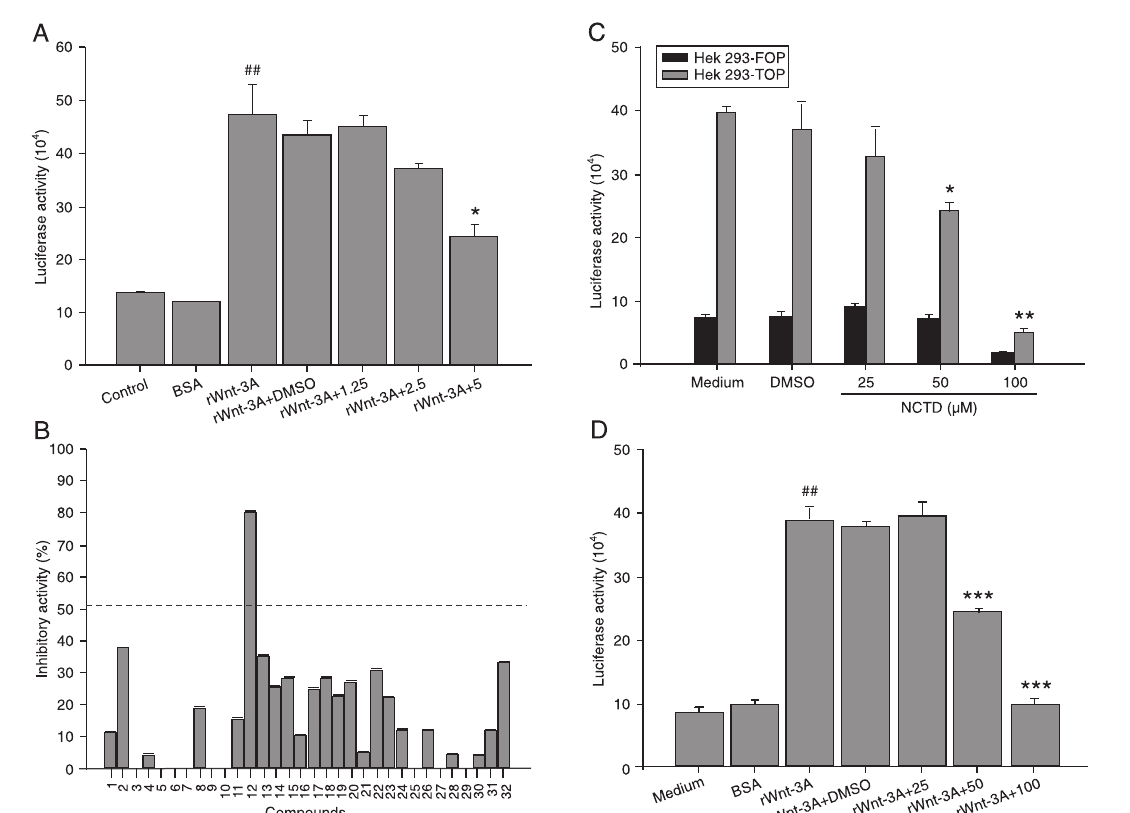
Figure 3. Effects of aspirin and 32 other compounds on luciferase activity in HEK 293-TOP cells induced with Wnt-3A proteins. A , B , HEK 293-TOP cells (1 x 10 4 ) were seeded into a 96-well plate for 24 h and then stimulated with rWnt-3A or Wnt-3A CM in the presence of aspirin (1.25, 2.5, and 5 mM) or the test agents (100 μM) for 24 h. Total cell proteins were extracted and luciferase activity was determined. C , HEK 293-TOP/FOP cells (1 x 10 4 ) were plated into a 96-well plate and then stimulated with Wnt-3A CM in the presence of NCTD (25, 50, 100 μM). D , HEK 293-TOP cells were cultured with rWnt-3A (400 ng/mL) and various concentration of NCTD (25, 50, 100 μM) for 24 h. Finally, total cell proteins were collected and subjected to luciferase assay. Each bar indicates the mean ± SD of three independent experiments. NCTD = norcantharidin. *P < 0.05, **P < 0.01, ***P < 0.001 vs HEK 293-TOP cells treated with Wnt-3A and 0.1% DMSO. ## P < 0.01 vs cells treated with 0.1% BSA (Student t